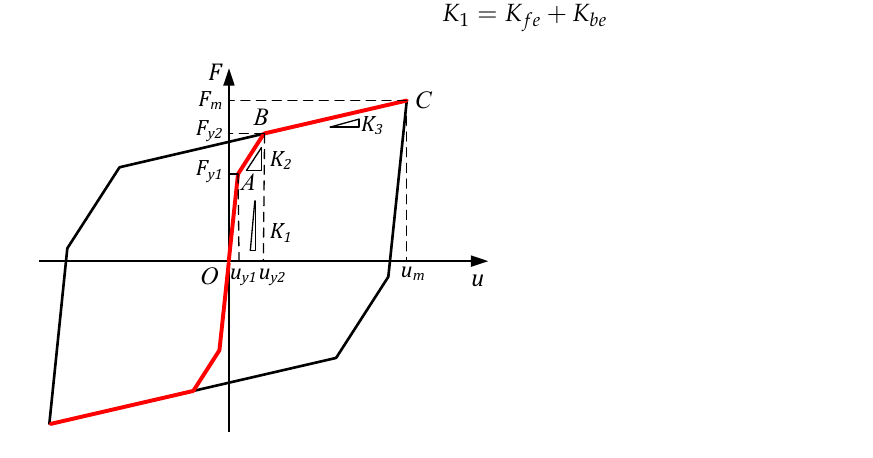
Figure 4. Force ‐ displacement relationship of FBRB. Figure 4. Force‑displacement relationship of